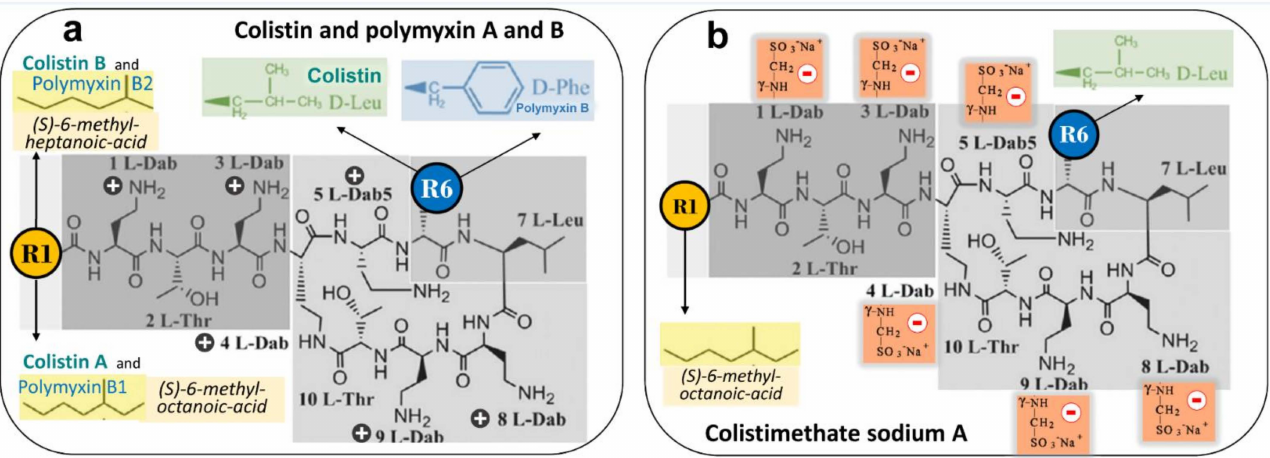
Figure 3. Chemical structures of polymyxin B (PMB), colistin and colistimethate sodium. ( a ) PMB is characterized by D-Phenyl and colistin by D-Leuc in position 6. Each antibiotic is a mixture of active components differing by the type of fatty acyl chain linked to the N-terminal diaminobutyric acid (Dab) residue. At physiological pH, Dab are positively charged + and interact with anionic phosphates of lipid A of LPS, thereby disrupting the bacterial outer membrane; colistin A and PMB1 = (S)-6-methyl-octanoic acid; colistin B and PMB2 = (S)-6-methyl-heptanoic acid; colistin C and PMB3 = octanoyl acid; colistin D and PMB4 = heptanoyl acid; colistin E and PMB5 = nonanoyl; colistin F and PMB6 = 3-hydroxy-6- methyloctanoyl acid. Light grey identifies the polar residues of the heptapeptide, light purple the hydrophobic motif within the heptapeptide ring and dark grey the N -terminal fatty acid analogues. ( b ) Colistimethate sodium, the inactive prodrug of colistin, is prepared from colistin by reaction of the free γ -amino groups of the Dab residues with formaldehyde followed by sodium bisulfite (methanesulfonate moieties). Colistimethate sodium A and B are defined by the fatty acid chain linked to Dab in position 1: (S)-6-methyl octanoic acid for colistimethate A and (S)-6-methyl heptanoic acid for colistimethate B. At physiological pH, methanesulfonate moieties are negatively charged—and Dab cannot interact anymore with anionic phosphates of lipid A of LPS, thereby precluding any bactericidal effect (see Figure 4). Adapted with permission from ref. [54]. Copyright 2009 American Chemical